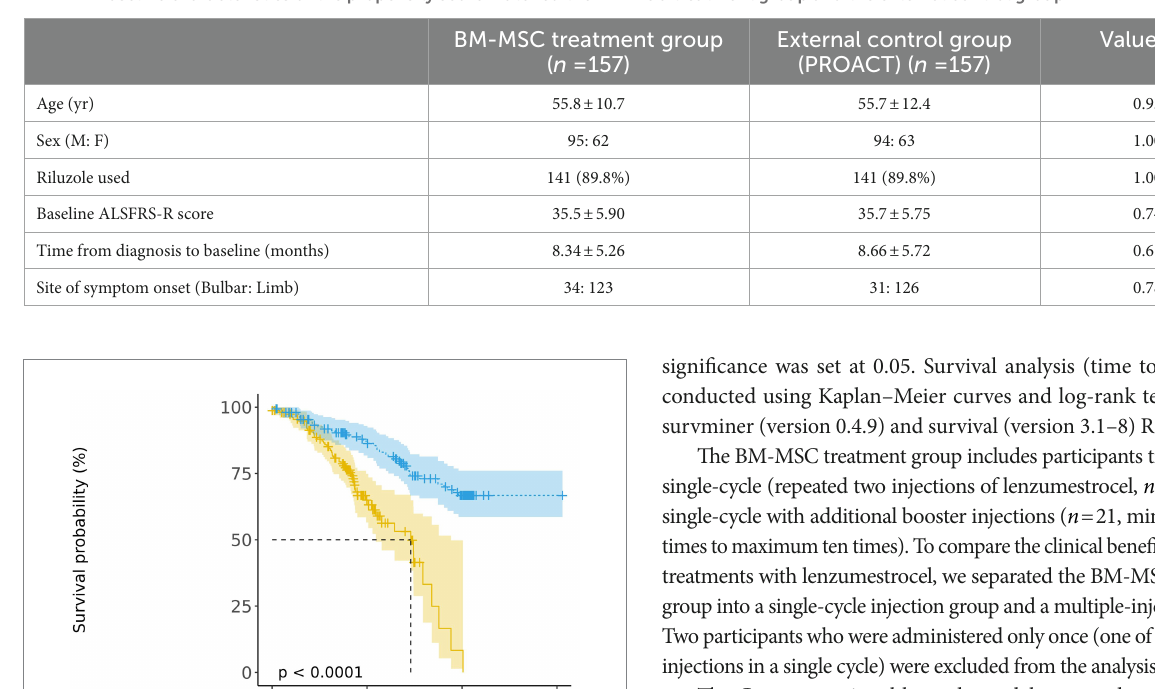
TABLE 1 Baseline characteristics of the propensity score matched the BM-MSC treatment group and the external control group.